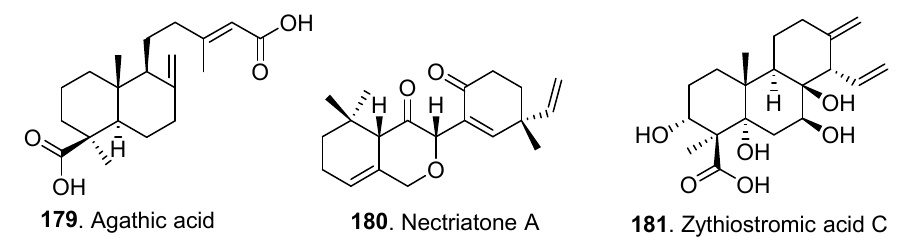
Figure 11. Diterpenoids isolated from Clonostachys fungi.